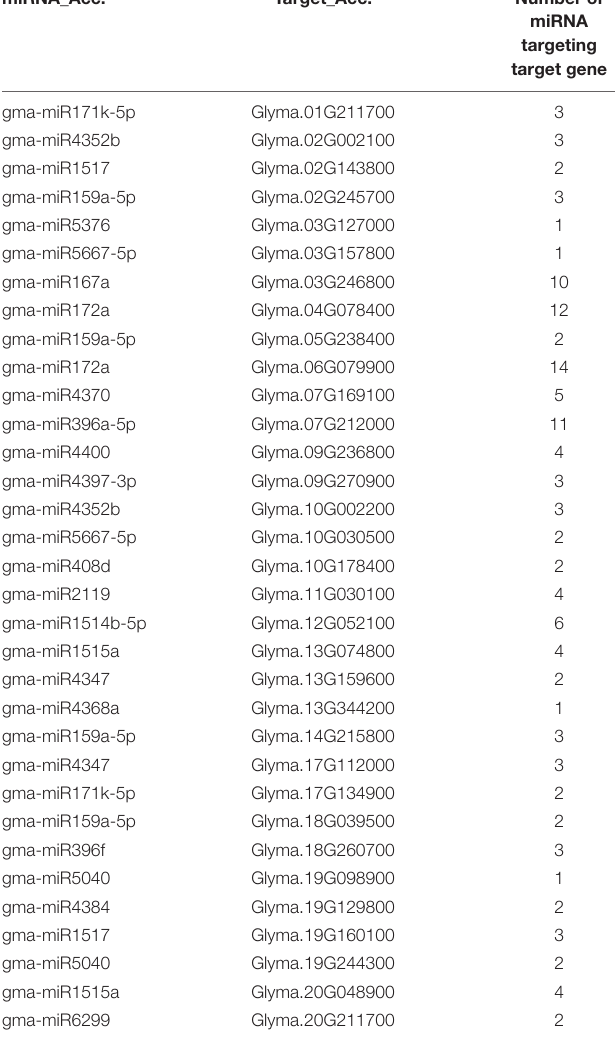
TABLE 2 | Identification of miRNA target sites in GmCML -transcripts of Glycine max.